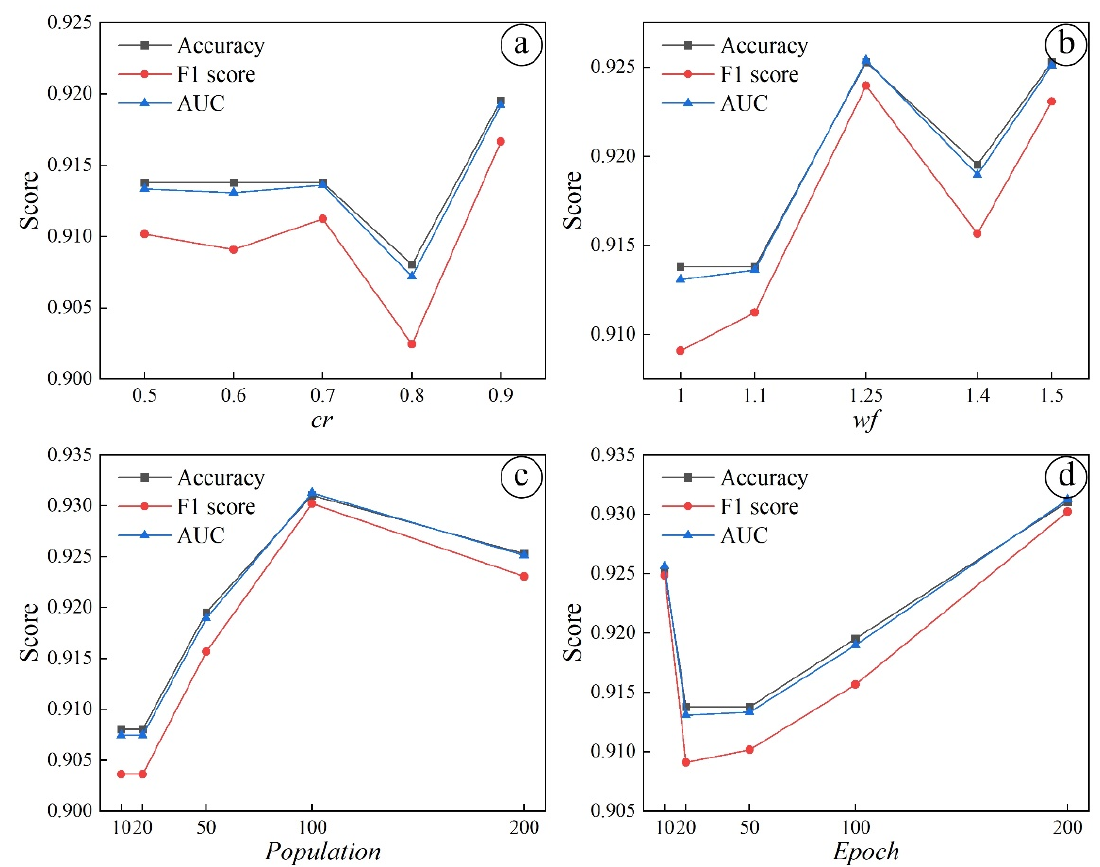
Figure 10. Parameter sensitivity analysis for GCO-SVC. Model performance over different values of ( a ) the difficulty of mutation ( cr ), ( b ) the coefficient of mutation ( wf ), ( c ) the total population ( Population ), and ( d ) the number of iterations ( Epoch ).